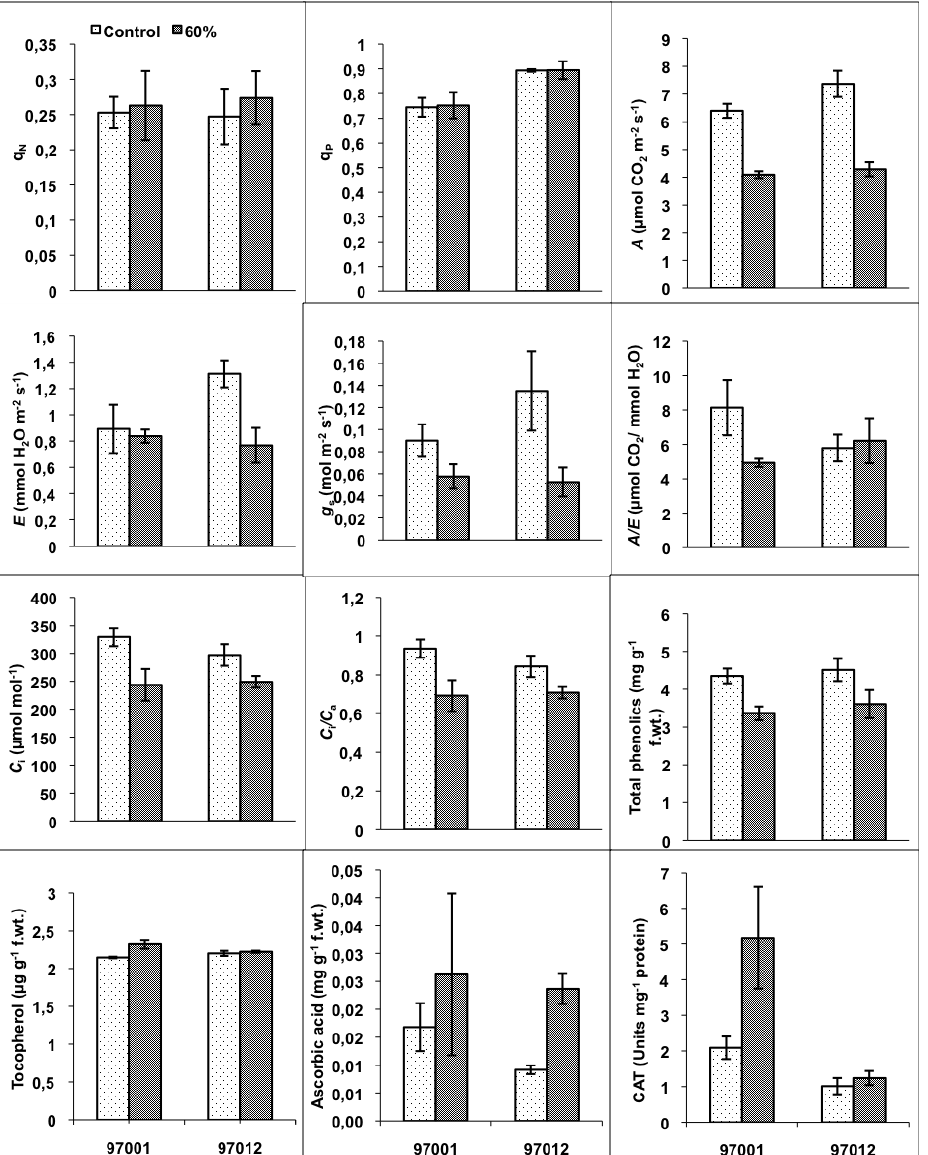
Fig. 2: Gas exchange characteristics and antioxidants of mungbean [ Vigna radiata (L.) Wilczek] when 30 day old plants were subjected to drought stress (Mean ± S.E.; n = 4).